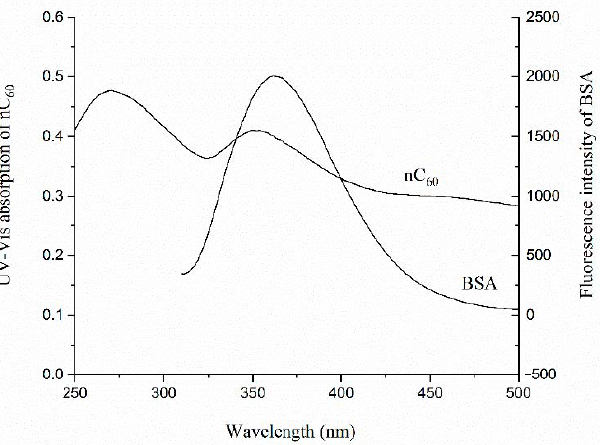
Figure 1. The overlap between the UV absorption spectrum of nC 60 and the fluorescence emission spectrum of proteins (bovine serum albumin (BSA)).